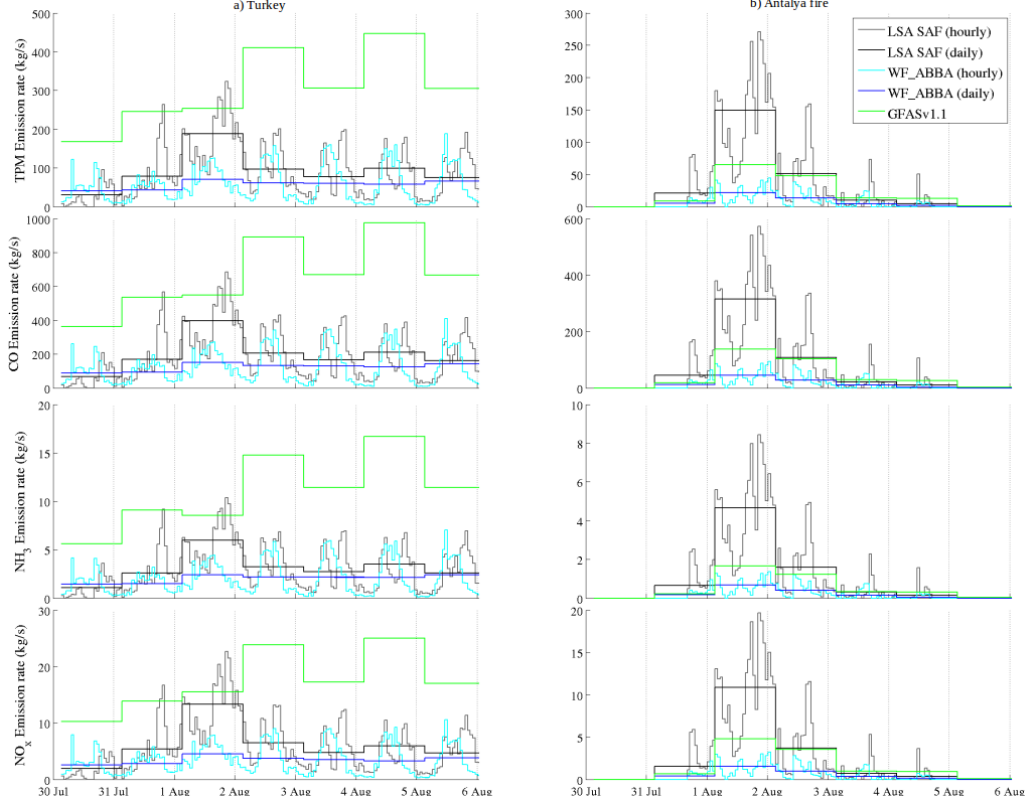
Figure 3. TPM, CO, NH 3 and NO x emission rates observed over the eastern Mediterranean (a) and over the Antalya fire (b) from 30 July to 6 August 2008. Cyan and blue lines are the hourly and daily WF_ABBA FRP. Grey and black lines are the hourly and daily LSA SAF FRP-pixel. Green line is the GFASv1.1.